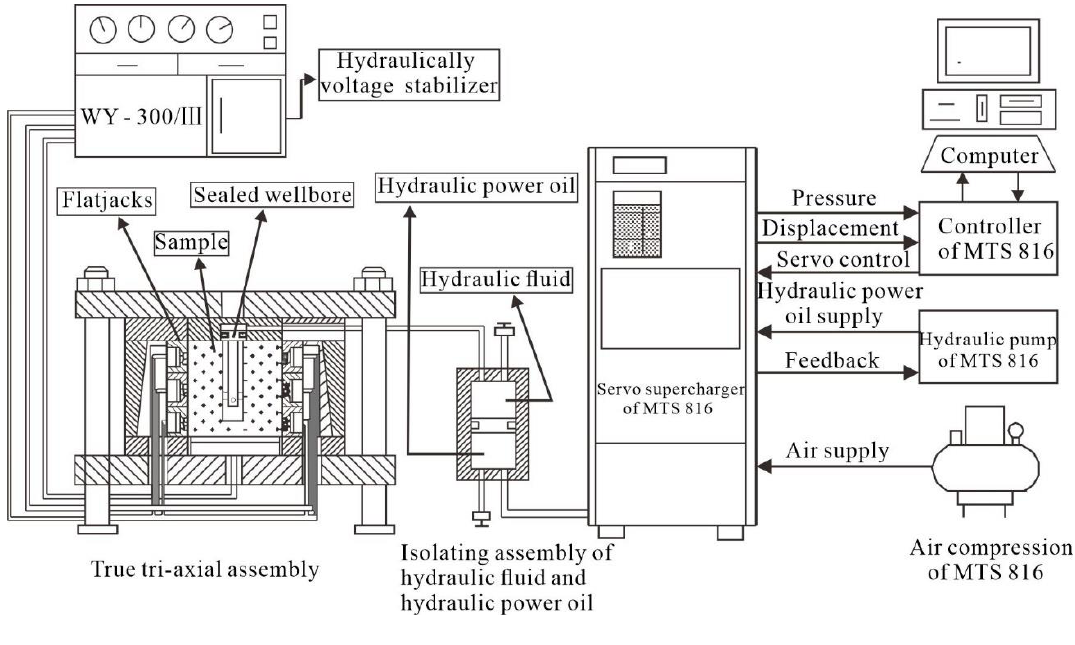
Figure 1. Laboratory physical simulation hydraulic fracturing experimental device system [58].